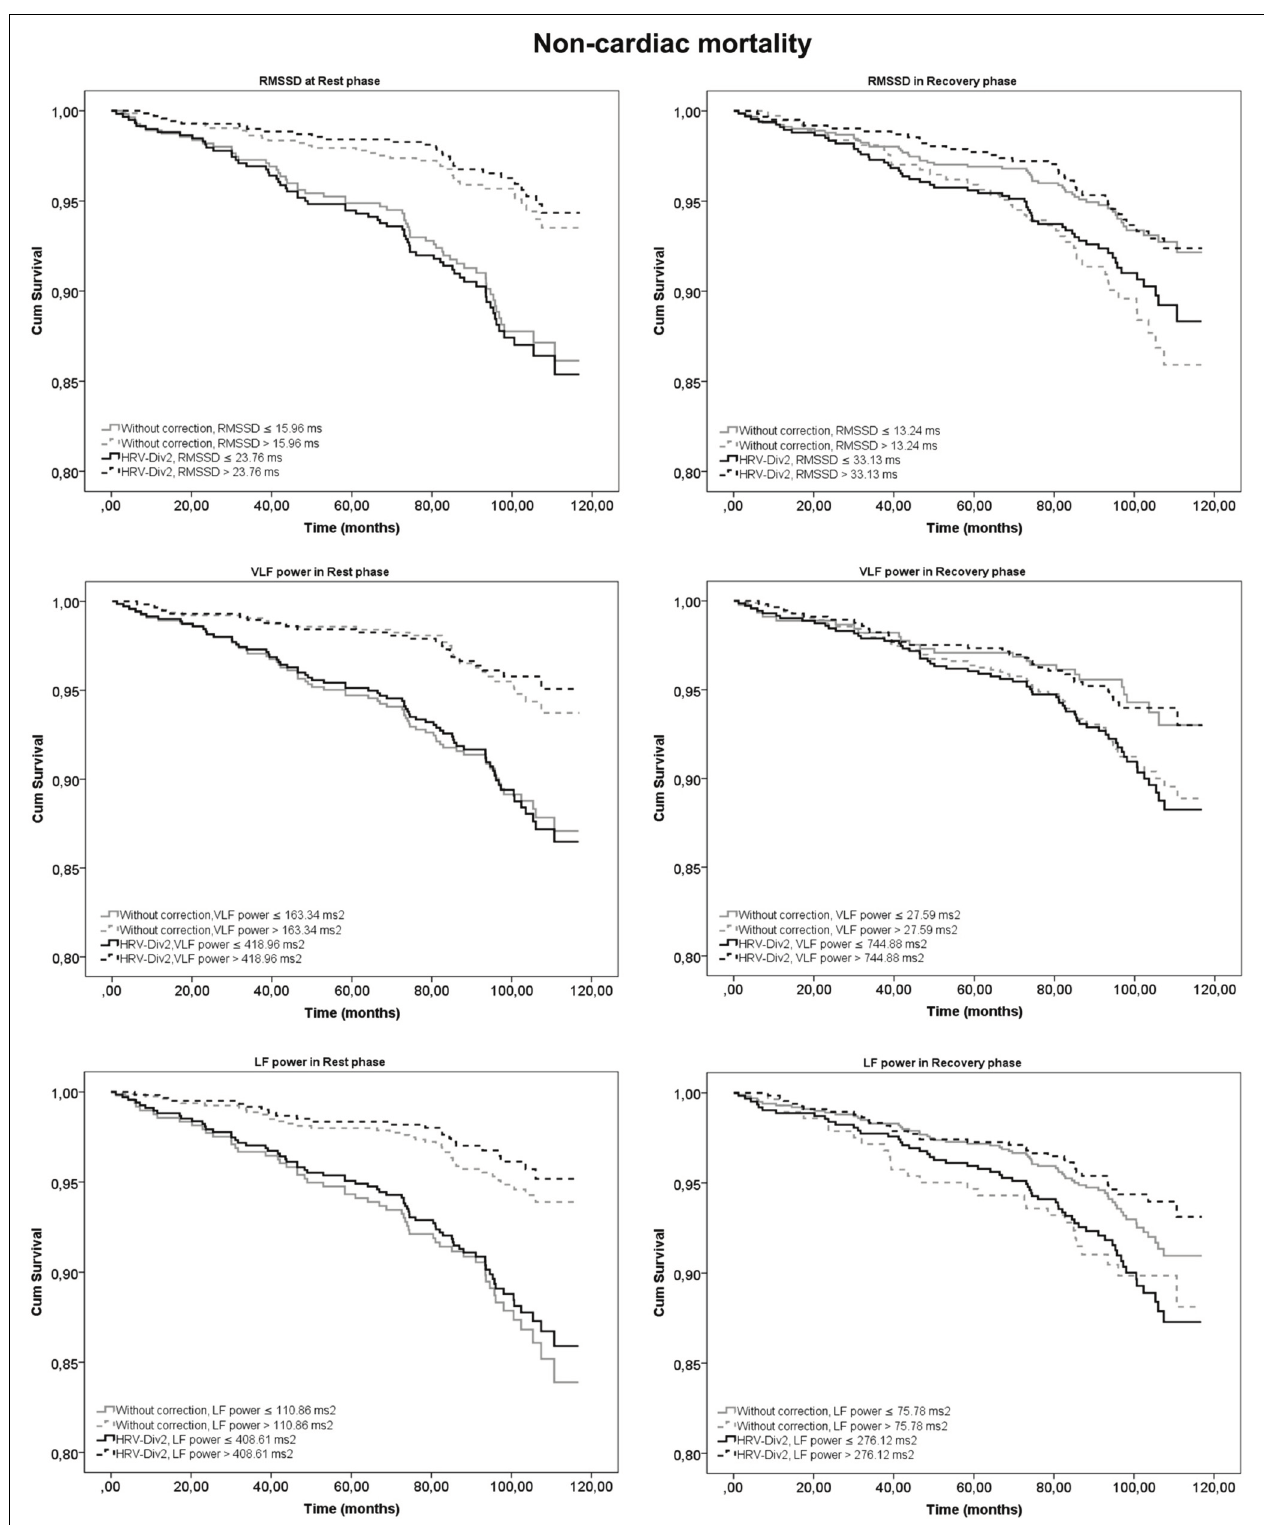
FIGURE 3 | Kaplan-Meier (KM) survival curves for prediction of non-cardiac mortality using heart rate variability (HRV) parameters at rest and recovery after exercise. Curves in gray represent HRV